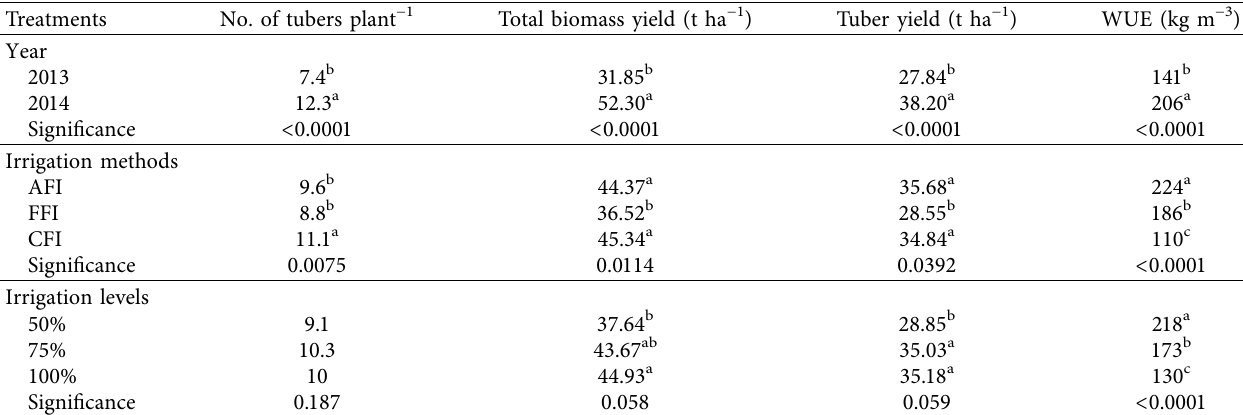
Table 3: Means for the main effects of methods and amount of irrigation water on the yield, yield attributes, and water use efficiency of